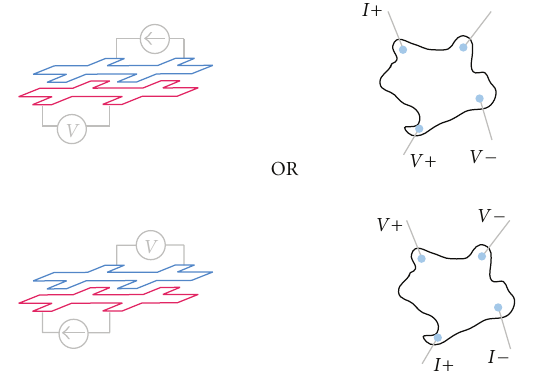
Figure 7: Schematic representation for the Coulomb drag measurement—notice that the measurement can be made in two ways. We may not look into the internal details of the sample and think of it as a “black box”. Then, it just corresponds to changing the voltage and current probes, as shown on the right.